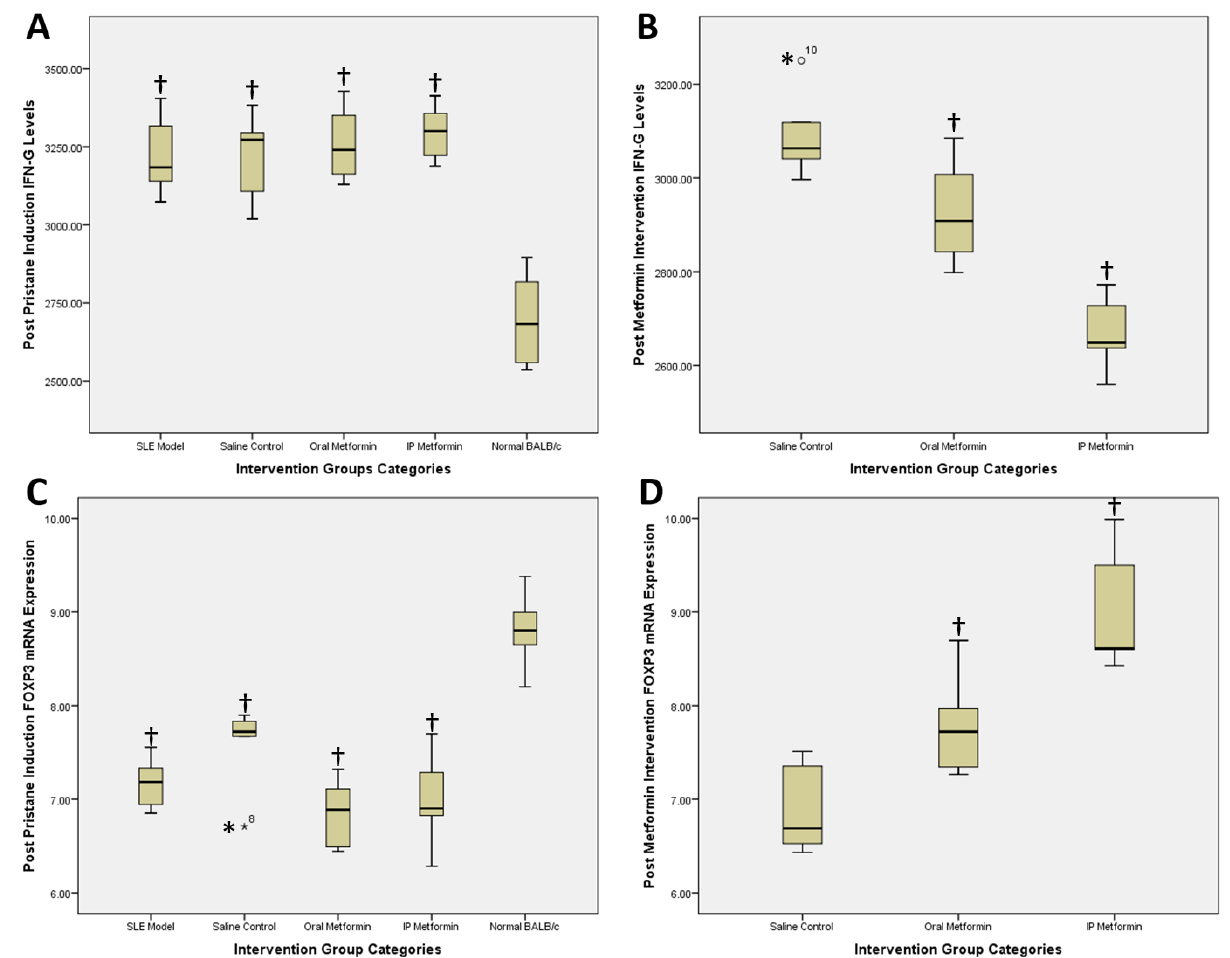
Figure 1. Post pristane induction and post metformin intervention IFN γ levels ( A and B ) and FOXP3 mRNA expression ( C and D ). †statistically significant compared to control groups;